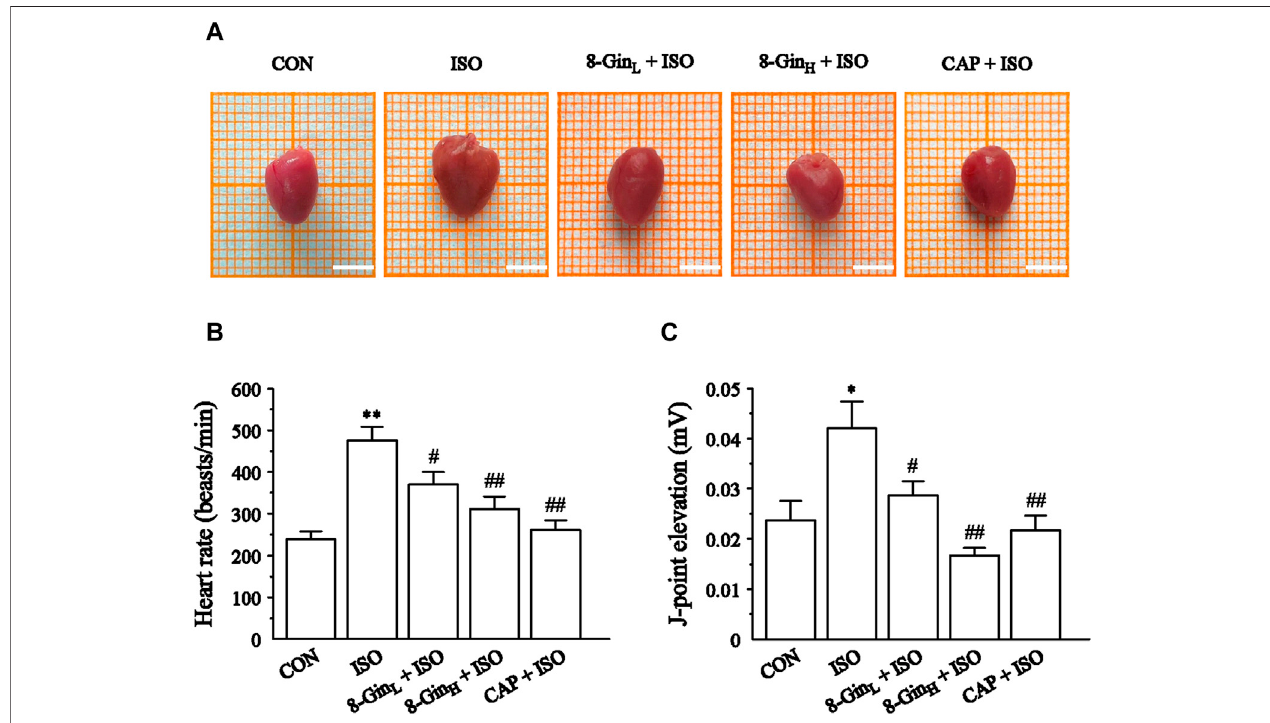
FIGURE 2 | Effects of 8-Gin on gross examination and cardiac function in mice heart. (A) Representative photos of mice hearts in fi ve groups. Scale bar (cid:1) 0.5 cm. (B, C) The heart rate and J-point elevation were recorded by electrocardiogram (ECG). Data are shown as the mean ± SEM, n (cid:1) 10. * p < 0.05, ** p < 0.01 vs. the CON group; # p < 0.05, ## p < 0.01 vs. the ISO